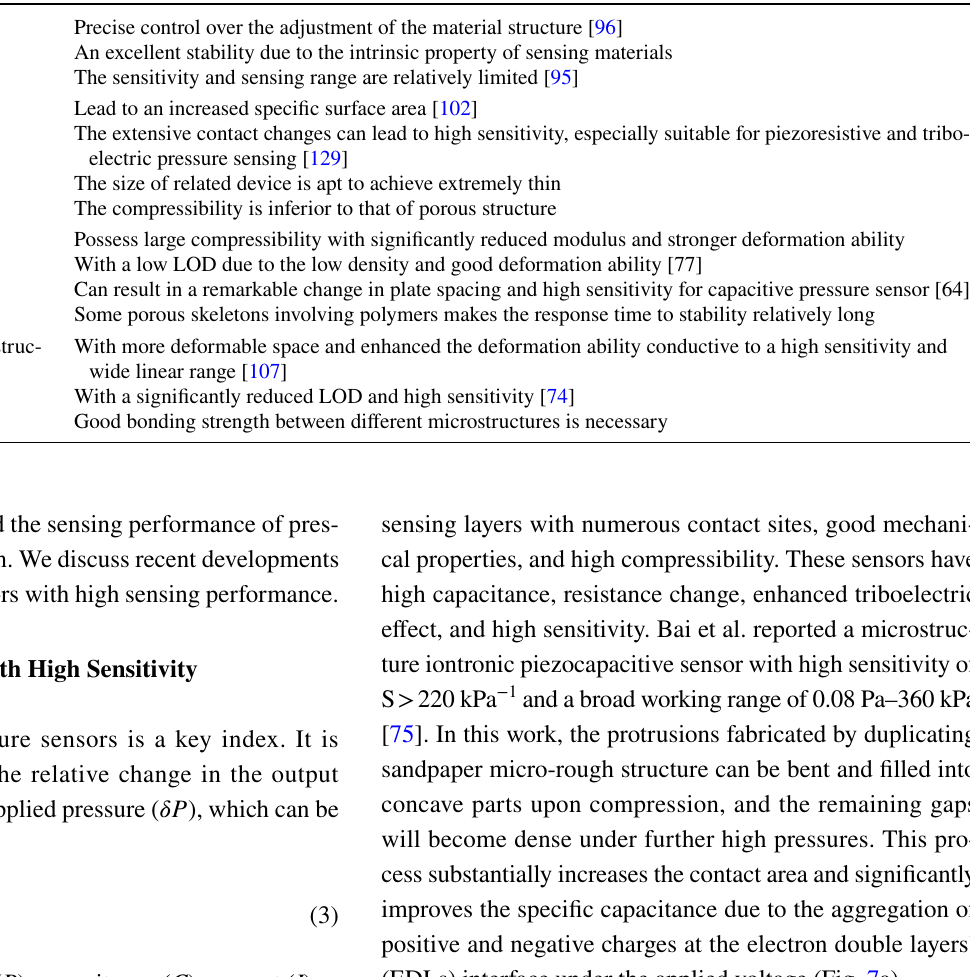
Table 3 Characteristics of different microstructures in flexible pressure sensors